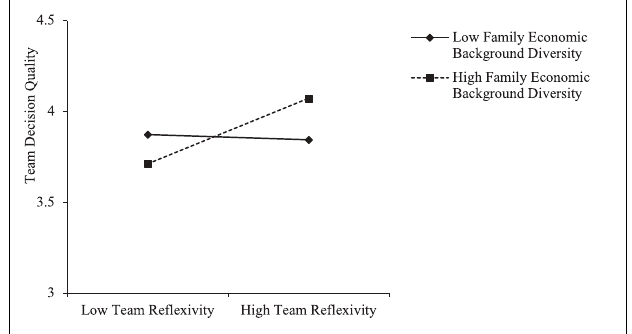
FIGURE 2 | Moderating effects of family economic background diversity on the relationship between team reflexivity and team decision